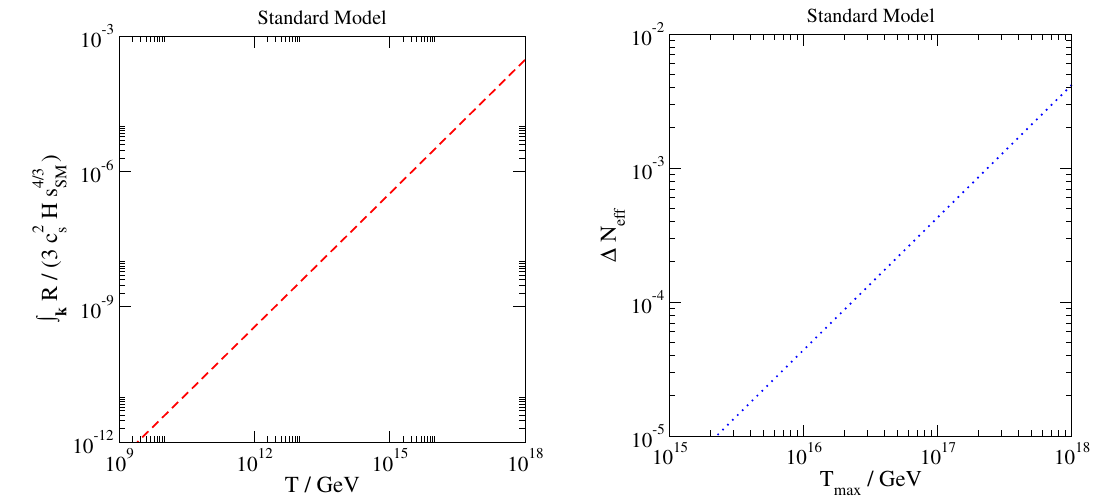
Figure 4 . Left: the integrated production rate of the energy density carried by gravitational radiation, normalized as in eq. (4.2), as a function of the temperature. Only the high-temperature end plays a signi(cid:12)cant role. Right: the contribution of the gravitational energy density to the parameter N (cf. eq. (4.1)), as a function of the highest temperature of the radiation epoch. Once e(cid:11) the experimental determination of N reaches the current theoretical precision, (cid:1) N e(cid:11) reheating temperatures above T (cid:25) 2 (cid:2) 10 17 GeV can be max